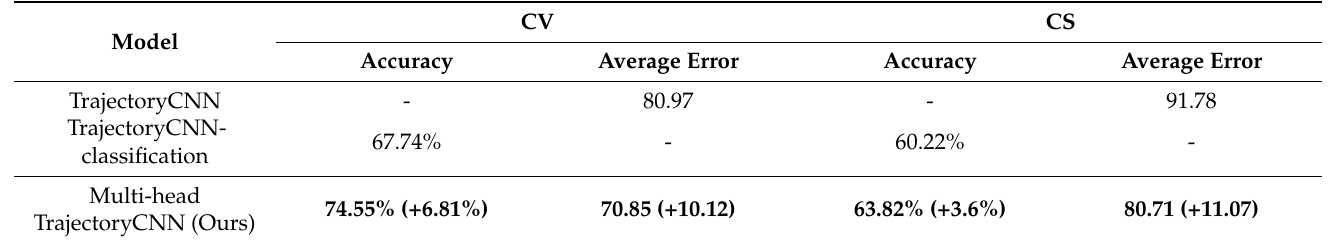
Table 1. Experimental results on NTU RGB+D, where “Average errors” denotes the average errors of MPJPE across all timestamps, “CV” denotes cross-view evaluation, and “CS” denotes cross- subject evaluation. The bold denotes the best results, and “+” denotes the improved performance of our